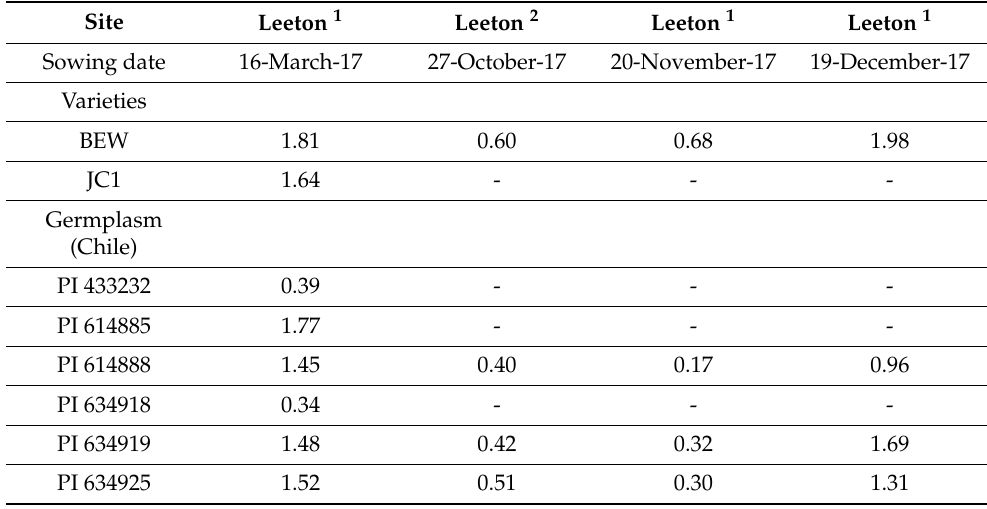
Table 11. Seed yield (t/ha) of quinoa varieties and germplasm at irrigated trial sites with a cold semi-arid